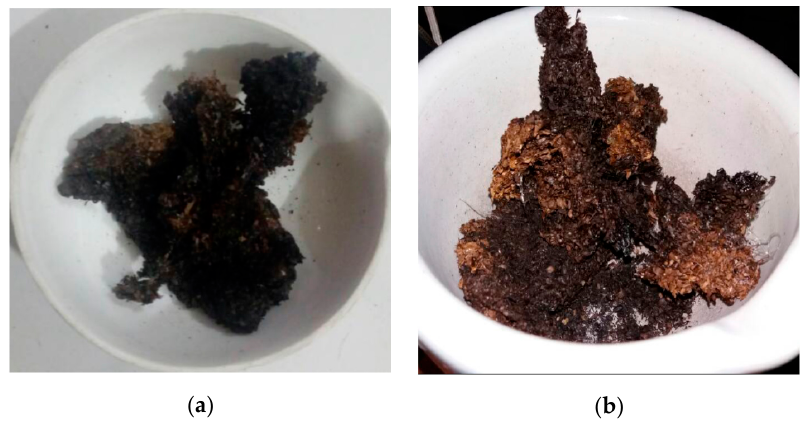
Figure 6. Flock of biomass particles in melting PP in co-pyrolysis with feed containing 50% weight of PP ( a ) and 75% weight of PP ( b ). Samples were taken when co-pyrolysis achieved 300 °C.